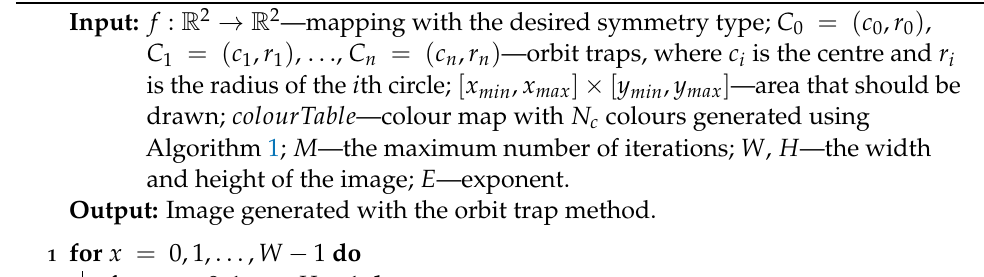
Algorithm 2: Orbit trap